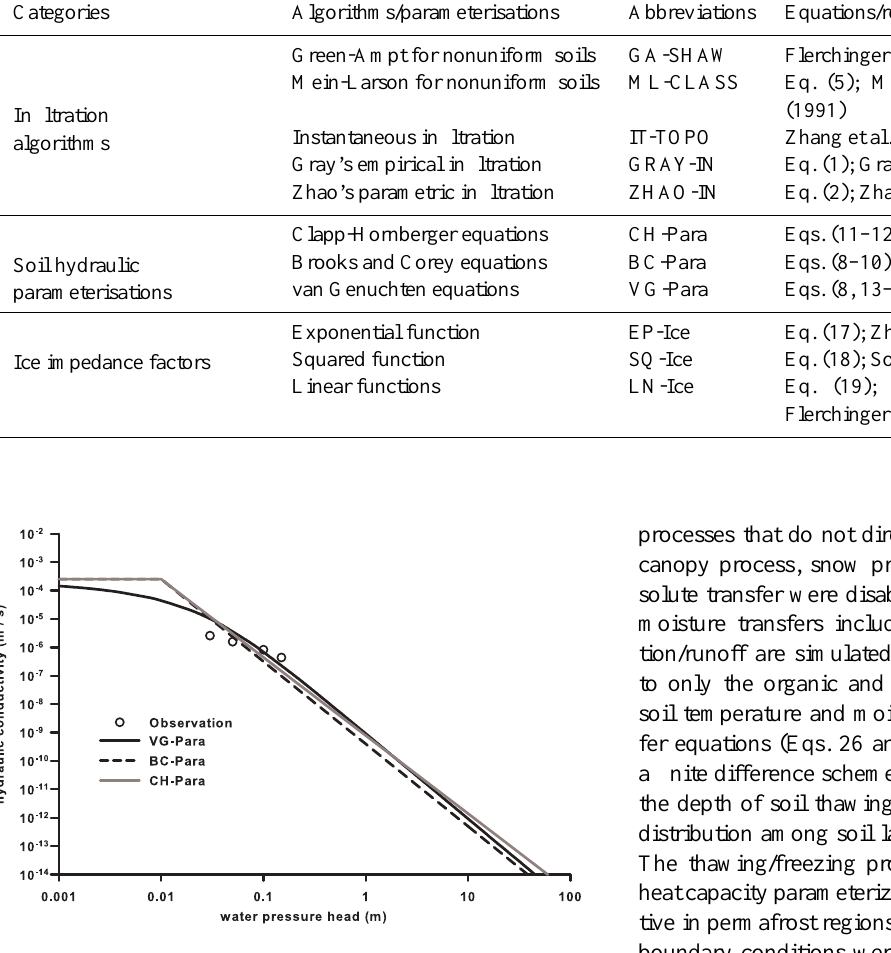
Fig. 2. Observed average unsaturated hydraulic conductivity of 16 soil samples from Wolf Creek and curves of Eqs. (10), (12) and (14) with parameters from Fig.